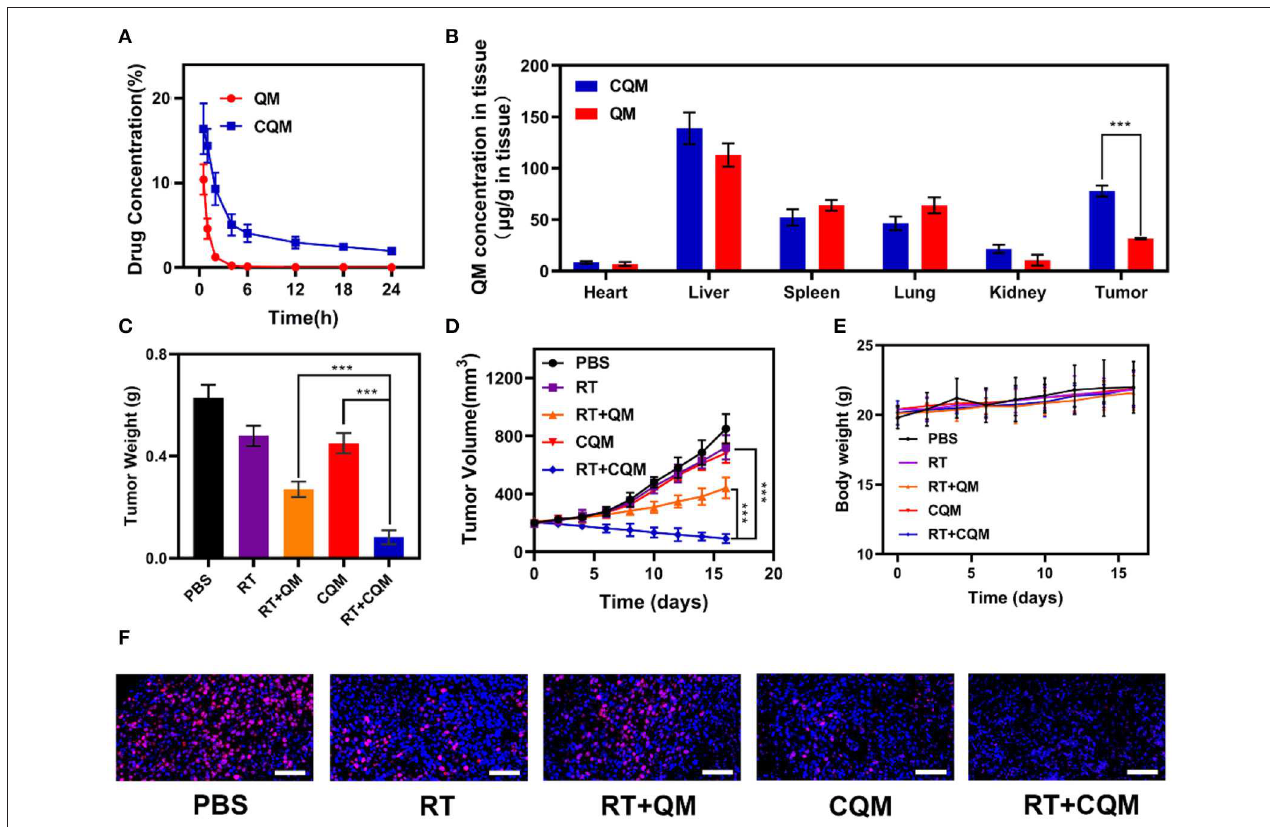
FIGURE 3 | Results of in vivo exposures. (A) Changes in tumor weight following treatment. (B) Change in tumor-volume curves of 4T1 tumor bearing mice after treatments. (C) Body weight of 4T1 tumor-bearing mice as recorded every 2 days following treatment. (D) Pharmacokinetic behavior of QM and CQM in mice following i.v. administration at doses of 5 mg/kg of MSNs. Data are presented as mean ± SD ( n = 3). (E) Quantitative analysis of QM biodistribution in tissues and tumors of tumor-bearing mice injected with QM or CQM at MSNs dose of 5 mg/kg, respectively. (F) Representative Ki-67 stained tumor slice images of mice following treatment. Scale bars: 100nm. Significant differences among groups as calculated using the Student’s t -test. *** P < 0.005.